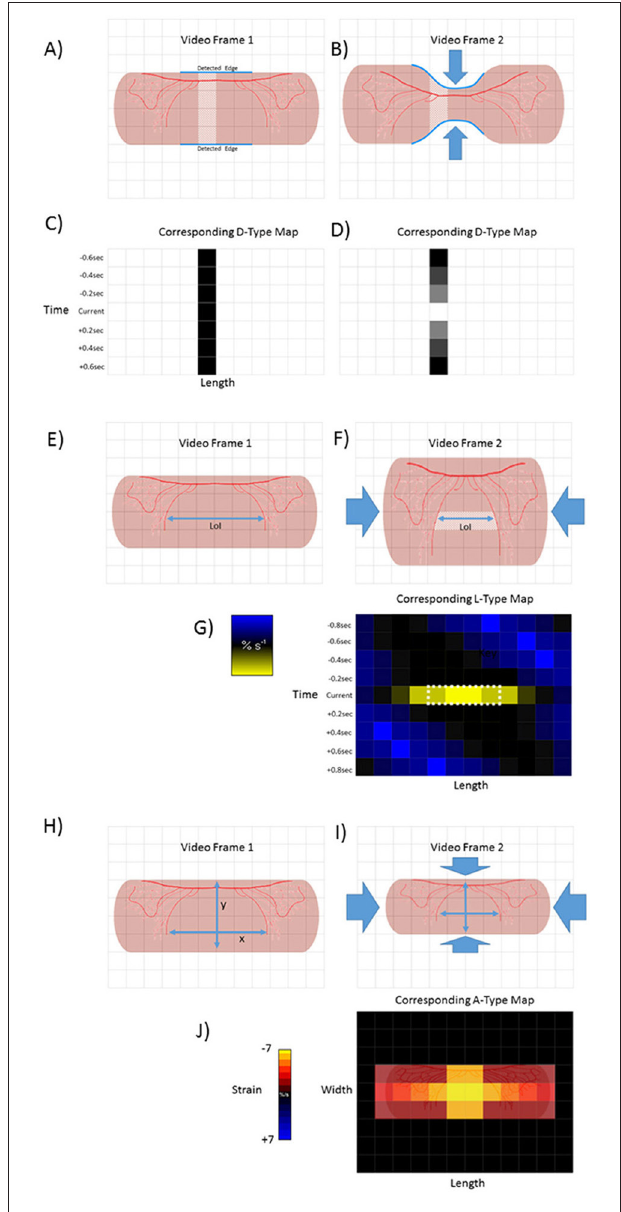
FIGURE 1 | Basic methodologies of D-type, L-type and A-type video-spatiotemporal mapping techniques. D-type ST maps (A–D) . The upper and lower edges of a structure (in this case a pink tubular segment of gut) are detected (blue line) and the number of pixels counted between the edges of successive columns (pale area). The totals are then color coded for each column within each frame. Hence the dark square in the in time series of D map below frame 1 (C). Circumferential contraction (frame 2) causes reduction in diametric profile and corresponding pixel total (light square in time series of D-type map below) (D) . L-Type ST maps (E–G) . The line of interest (LOI) that is to be used as a datum point for quantification of length-wise movement in successive frames is chosen (blue line). The color coded magnitudes of changes in distance (strain) between distinctive features (in this case red vascular markings) on successive video frames (strain rate) are plotted for each pixel along the length of the LOI (in this case shown only for one set of distinctive features between video frame 1 and 2) A-type ST maps (H–J) . The